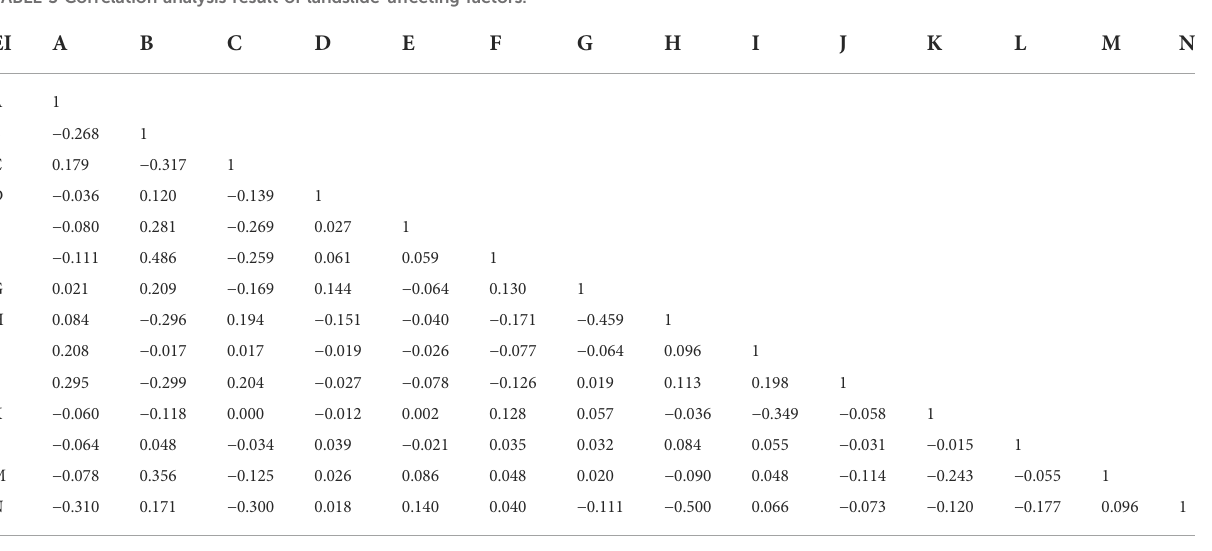
TABLE 3 Correlation analysis result of landslide-affecting factors.